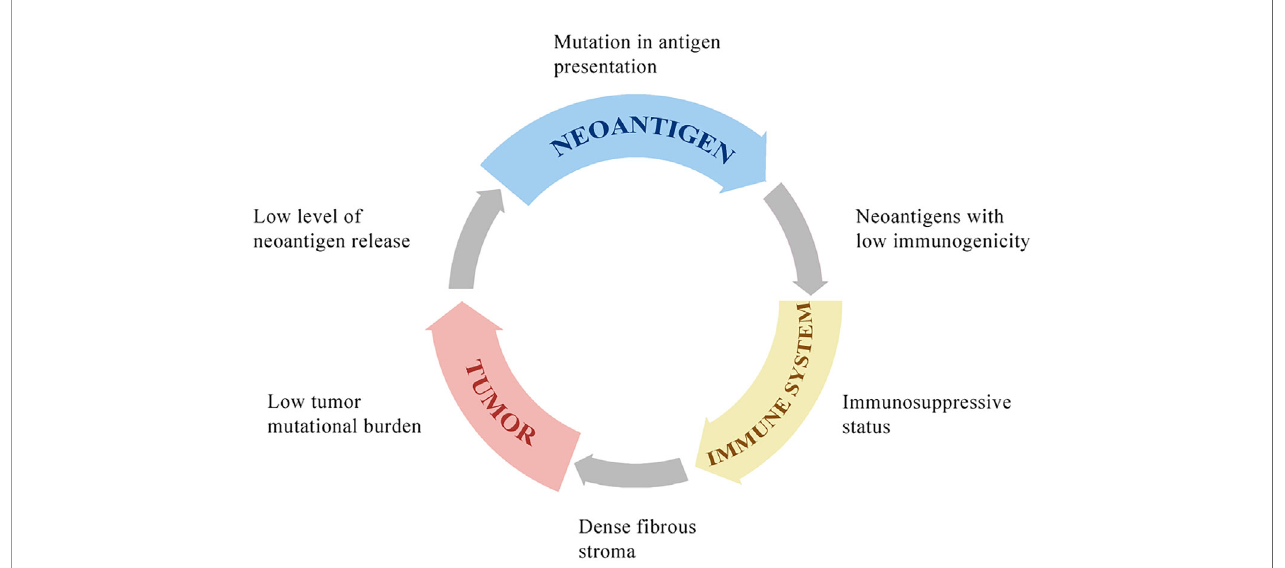
FIGURE 1 | The potential mechanisms of resistance to immunotherapies. HCC with low tumor mutational burden releases few neoantigens. The mutation in antigen presentation pathways also inhibits tumor-speci fi c peptide presentation. Most of these neoantigens cannot drive effective anti-tumor immunity because of low immunogenicity. The immune system in the tumor microenvironment is under immunosuppressive status, with few effector CD8 + T cells, many regulatory CD4 + T cells, and other immunosuppressive cells, which is associated with poor clinical response to immunotherapy. The dense fi brous stroma around tumor islets inhibits immune cells ’ access to the